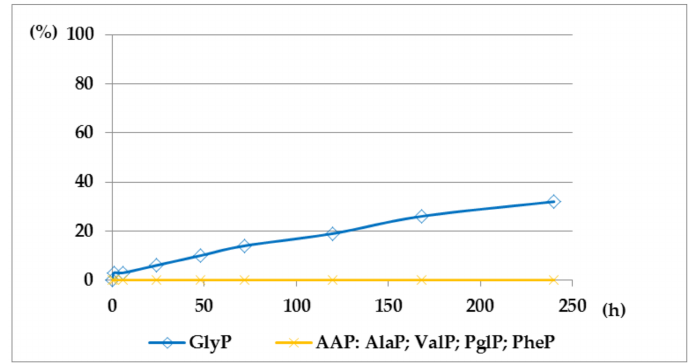
Figure 6. A solution of 0.1 M 1-(benzoylamino)alkylphosphonic acids Bz-AA P in 2 M KOH reacted at 25 ◦ C, which was monitored by 31 P NMR [DD (%) vs. time (h)]. Thus, the presented graphs illustrate much higher stability of benzoyl-derivatives Bz-AA P (Bz-Gly P : DD 200h ~30%; for Bz-Ala P and Bz-Pgl P : DD 200h < 3%) in comparison with acetyl-derivatives Ac-AA P (Ac-Gly P : DD 200h ~70%; for Ac-Ala P : DD 200h ~20%; and Ac-Pgl P : DD 200h < 7%).